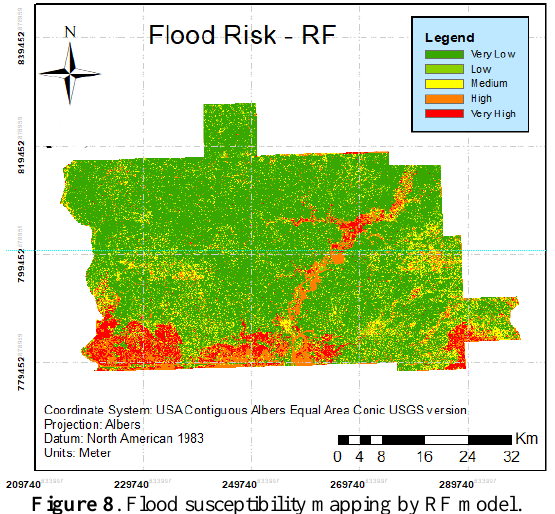
Figure 8 . Flood susceptibility mapping by RF model.